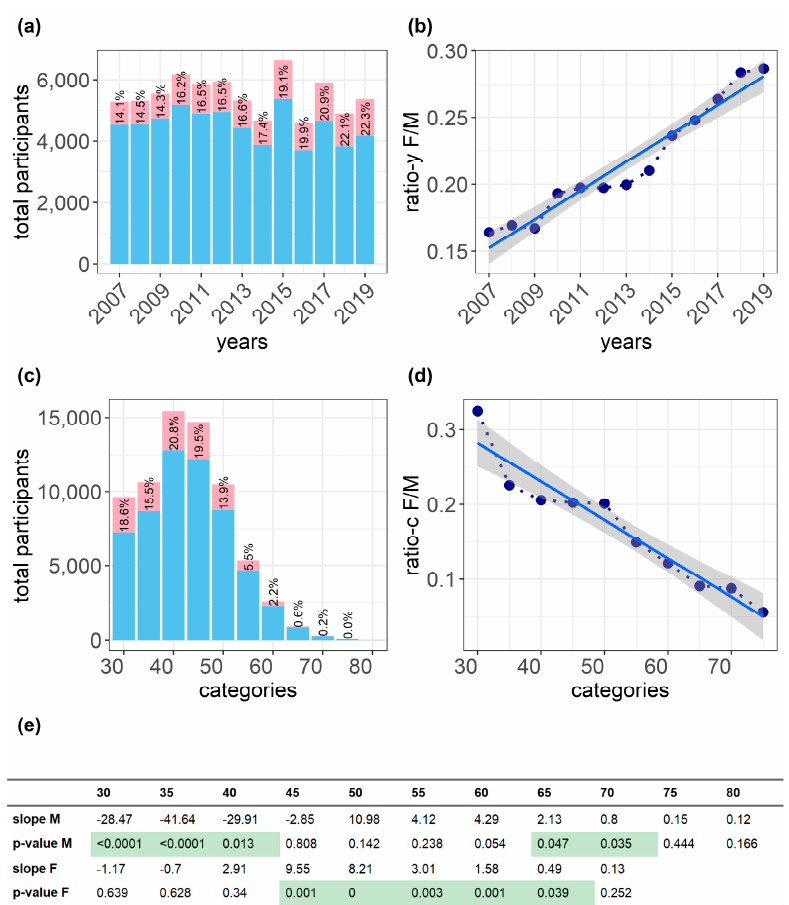
Figure 1. Distribution of participants in the 2007–2019 editions of the VM: ( a ) Total number of participants in each year from 2007 to 2019; males are represented in blue and females in pink; the percentage of female participants with respect to the total participants by year is reported in the pink bars. ( b ) Linear regression of female vs. male ratios by year (ratio-y F/M). The confidence interval is shaded in gray. Real data are plotted as points connected with dotted lines. ( c ) Total numbers of participants by category; males in blue and females in pink; the percentage of female partic- ipants with respect to the total number of participants per year is reported in the pink bars. ( d ) Linear regression of female vs. male ratios by age category (ratio-c F/M); the dotted line shows the trend of the female vs. male ratio for each category. Real data are plotted as points connected with dotted lines. ( e ) Slope coefficients computed by linear regression on the number of participants of each age category and gender in the 13 editions of VM. M = male, F = female; p -values < 0.05 are considered statistically significant, and p -values < 0.001 are considered highly significant. 3.2. Speed Analysis by Category in the 13 VM Editions The mean speed values observed over the 13 editions were analyzed either by in- cluding all speeds (AD) or by limiting the analysis to the TOP performers reported in each category according to gender (Figure 2).